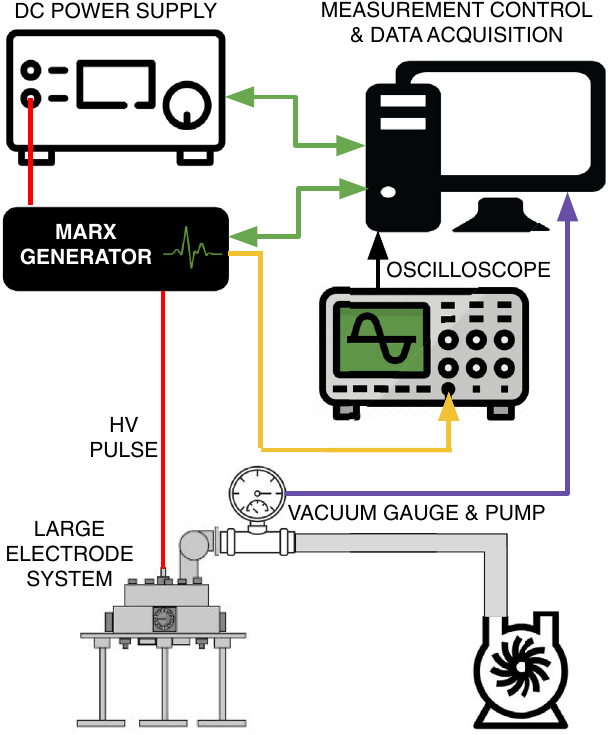
FIG. 1. A schematic of the pulsed dc system used in the